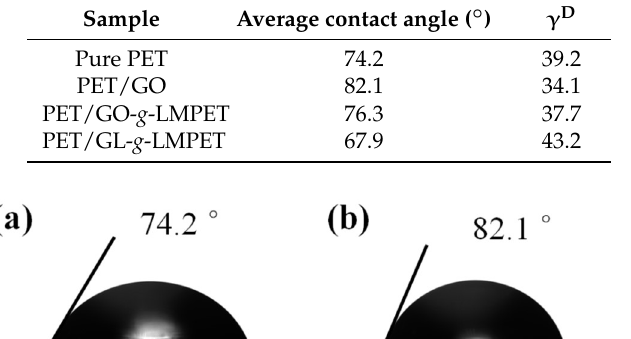
Table 1. Contact Angle and surface free energies of Water on various nanocomposites.